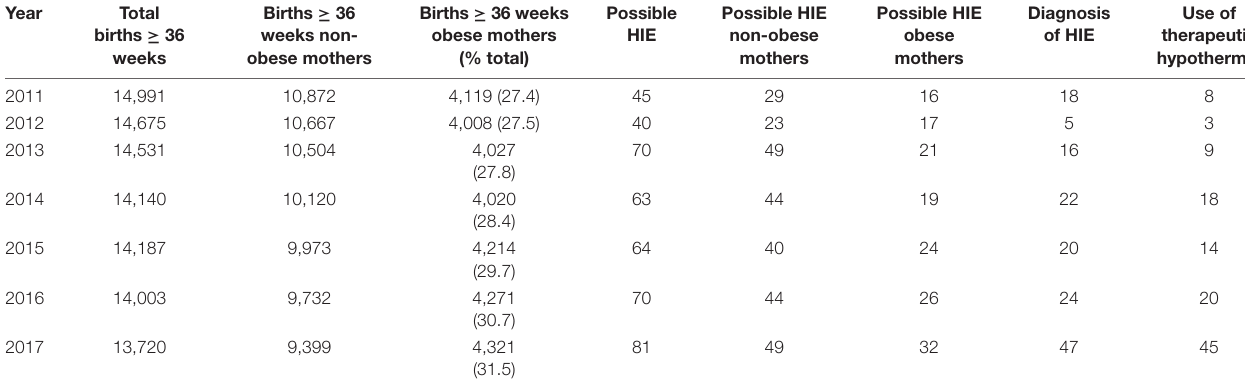
TABLE 1 | Hypoxic ischemic encephalopathy and hypothermia use by year.